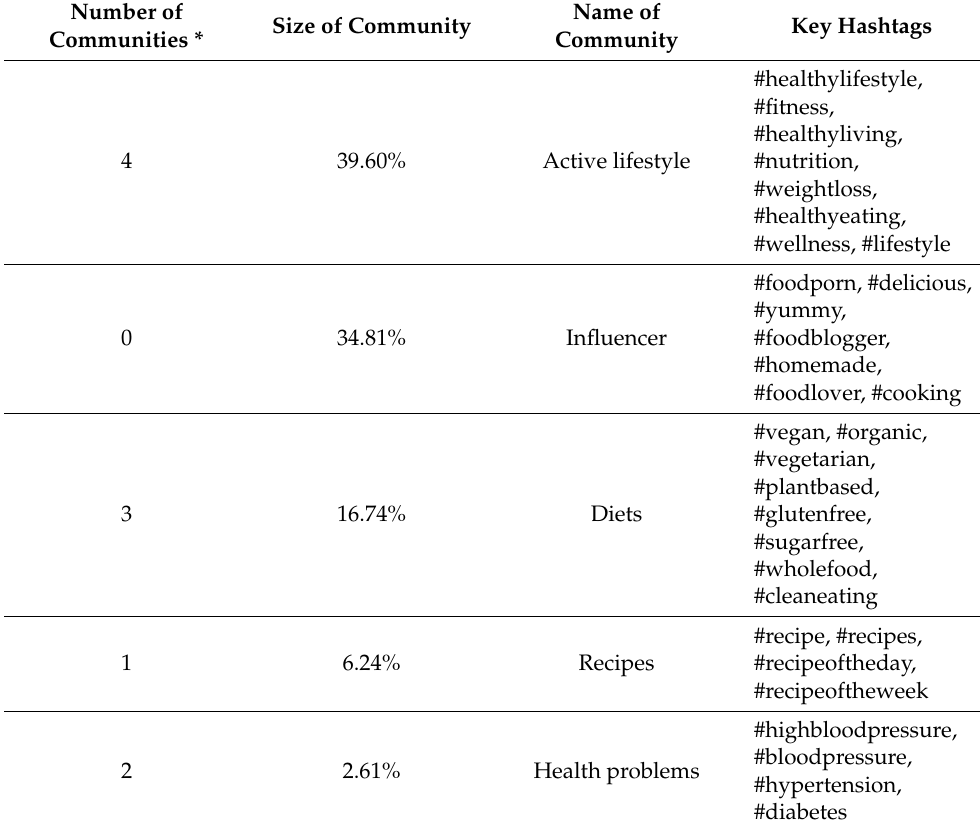
Table 2. Communities extracted from the reduced network. Number of Size of Community Communities *